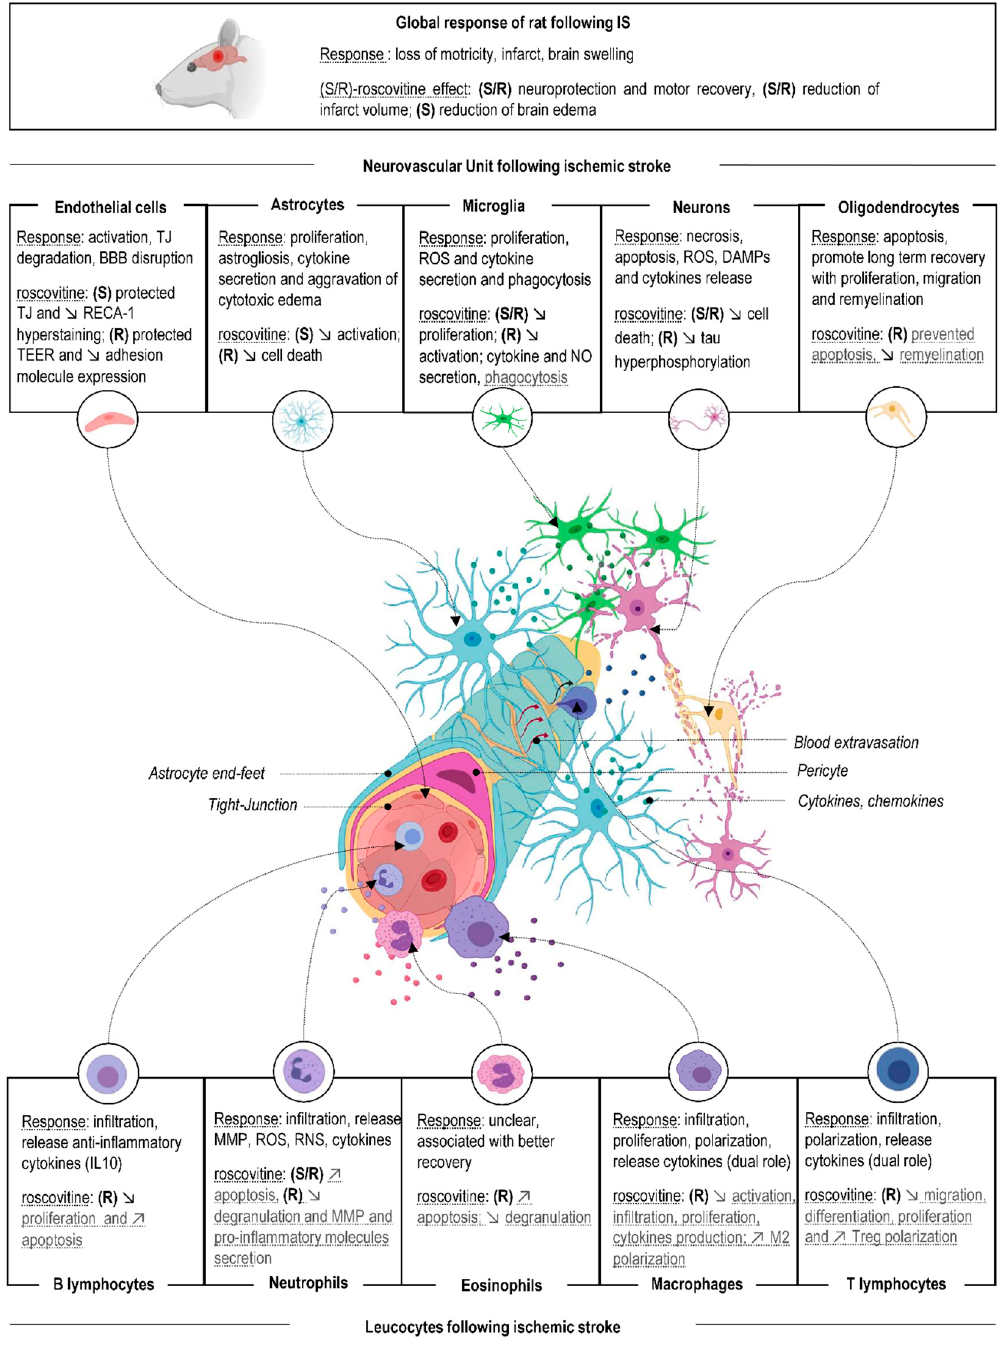
Figure 2. ( R ) and ( S )-roscovitine effect on Neurovascular Unit (NVU) and immune cells following ischemic stroke. A box was assigned to each cell from the NVU, in which two topics are described: the cell response after ischemic stroke, and the cellular effect of ( R ) and ( S )-roscovitine. The box content is a summary of the data described for each cell type. For more detailed information, please refer to the full text of the manuscript. The ( R )-roscovitine is represented by ( R ) and the ( S )-roscovitine by ( S ). Black text means that the effect of roscovitine was observed in ischemic stroke model in vitro or in vivo. Grey text with dashed highlights means that the ( R ) or ( S )-roscovitine effect was observed in other non-ischemic models, in vitro or in vivo. Created with